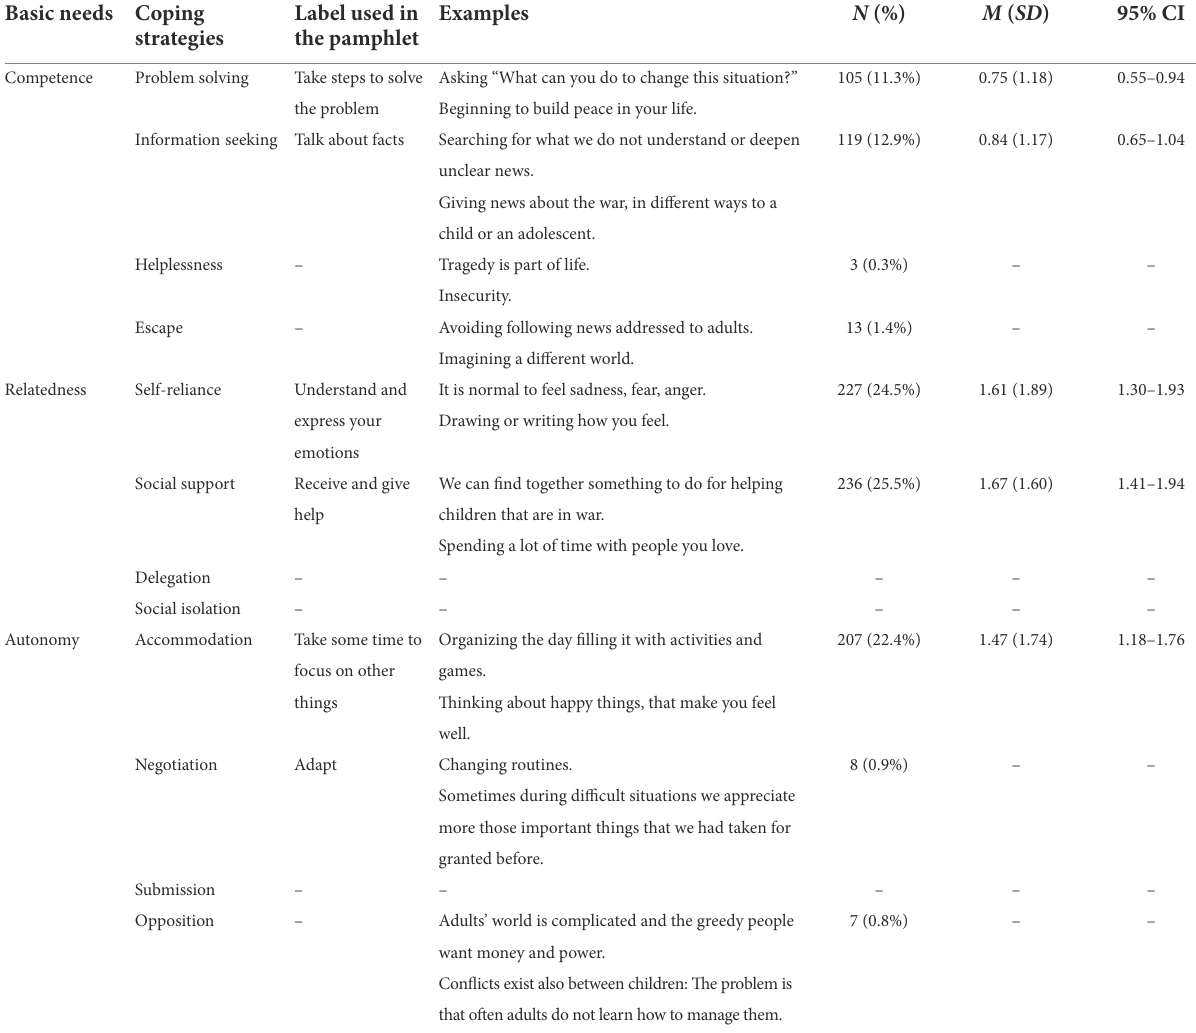
TABLE 1 Families of coping strategies (Zimmer-Gembeck and Skinner, 2011). Basic needs Coping